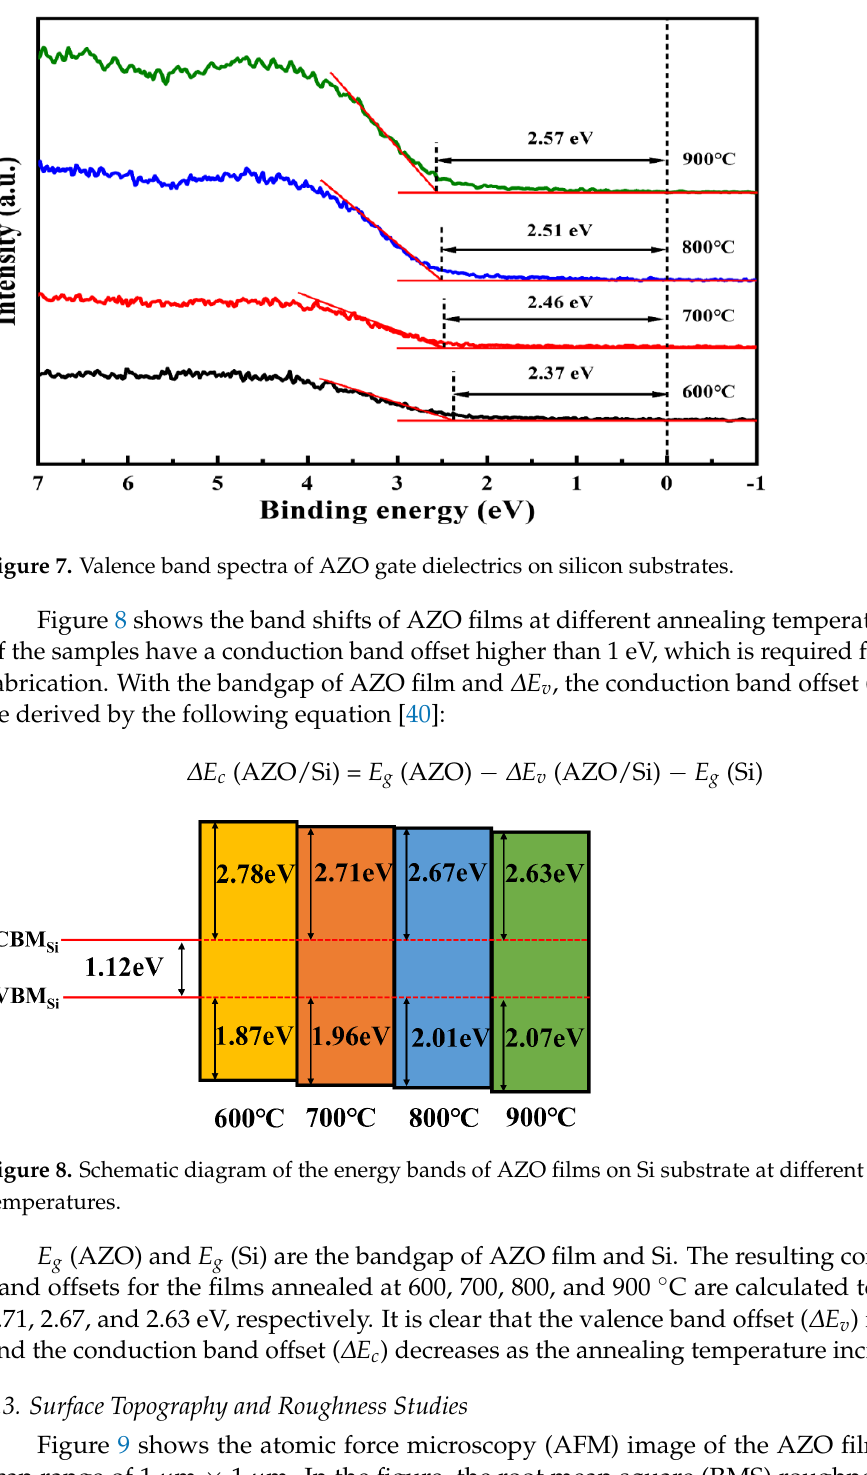
Figure 8. Schematic diagram of the energy bands of AZO films on Si substrate at different annealing temperatures.